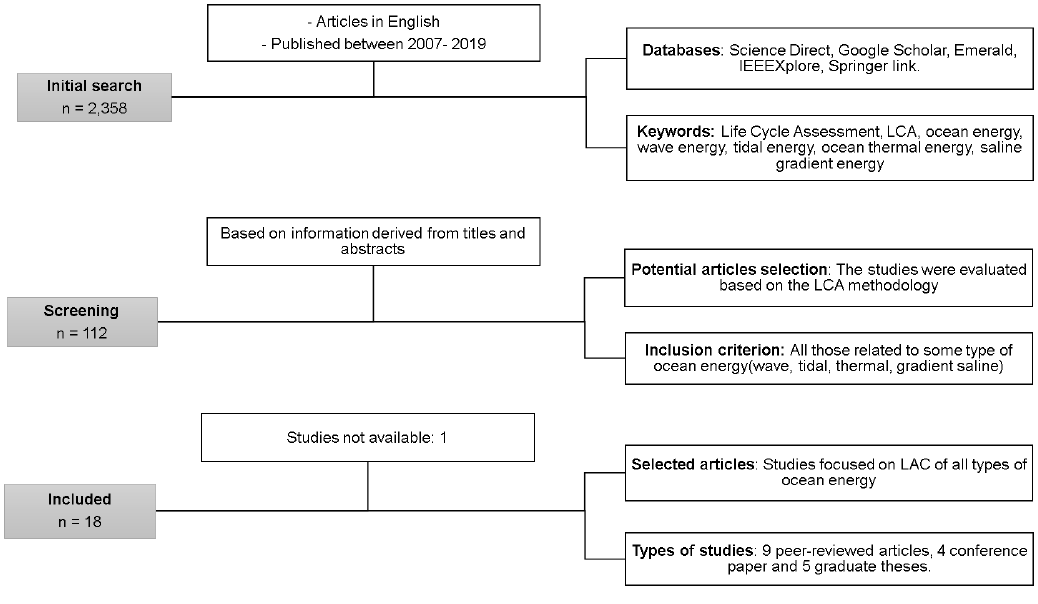
Figure 2. Systematic methodology review.